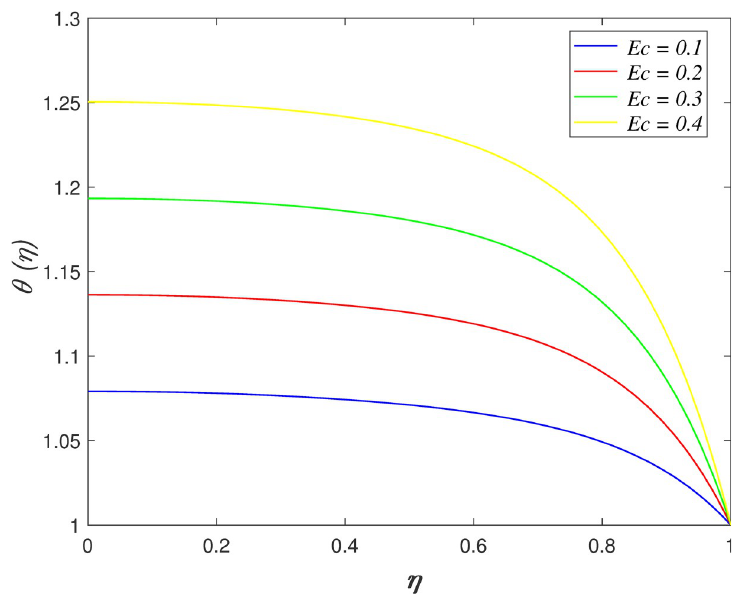
Fig 17. Impact of Ec on